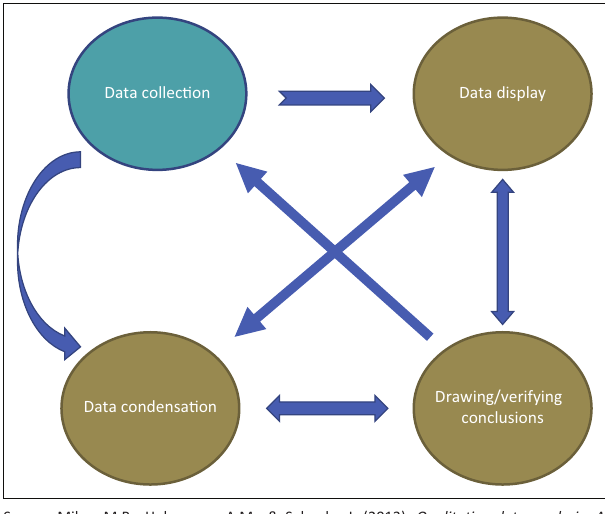
Data collec(cid:23)on Data